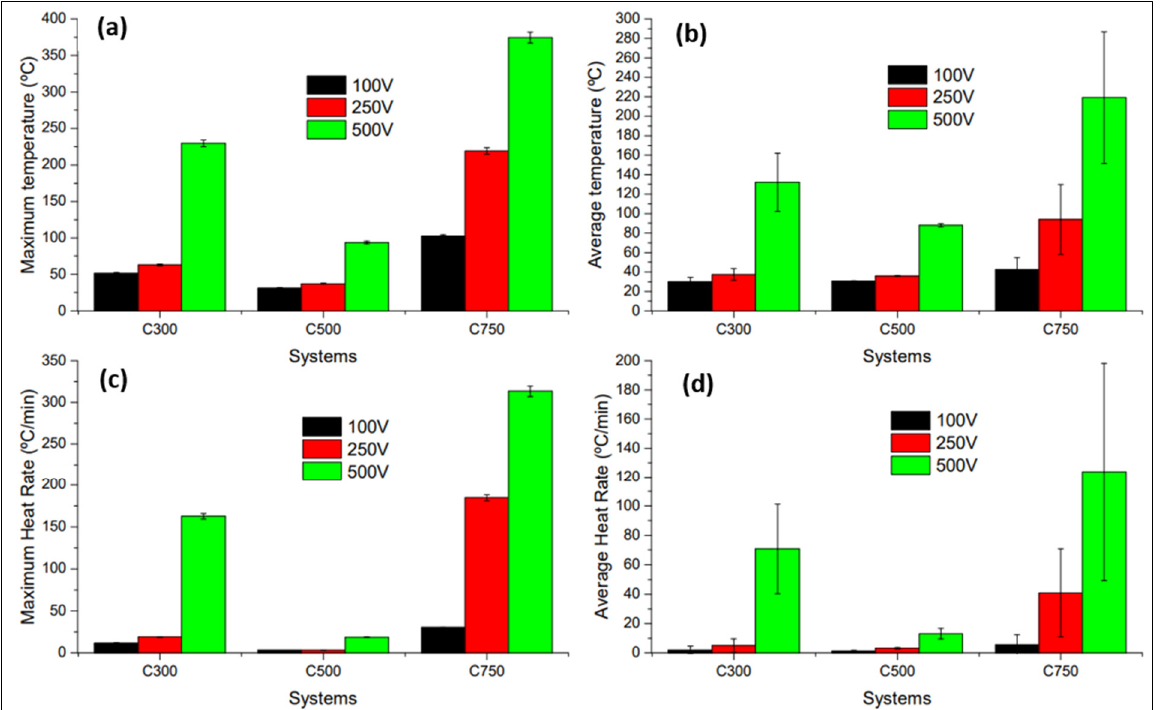
Figure 15. Values of maximum temperature ( a ), average maximum temperature ( b ), maximum heating rate ( c ), and average maximum heating rate ( d ) achieved by the application of different voltages (100, 250, and 500 V) on different systems manufactured for 30 min of sonication.